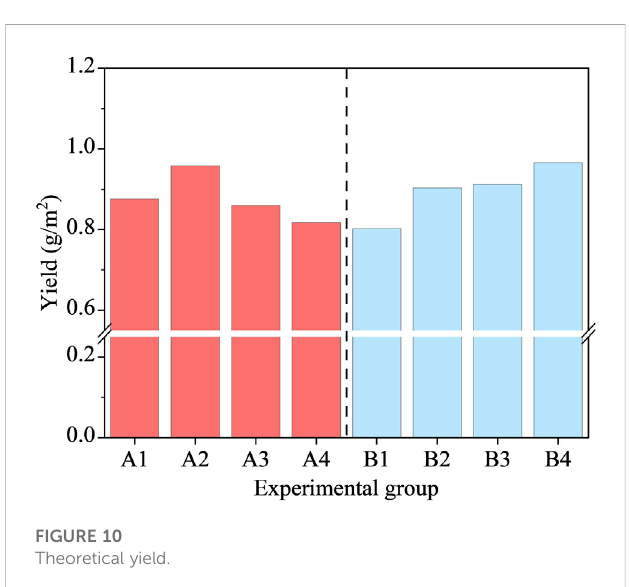
FIGURE 10 Theoretical yield.